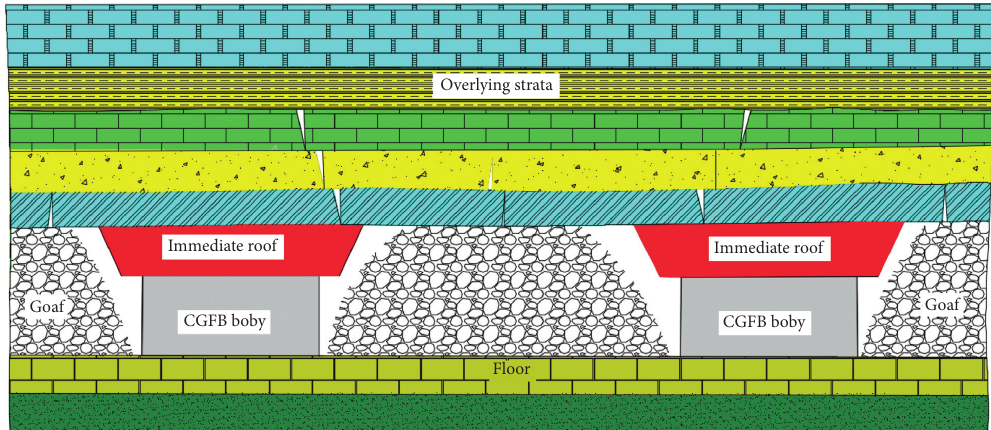
Figure 2: Basic principles of strip CGFB